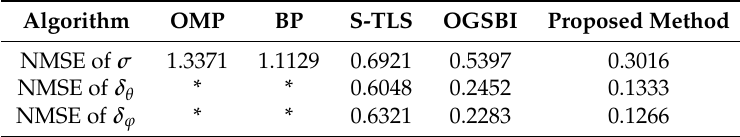
Table 3. NMSEs of 3D image and off-grid bias